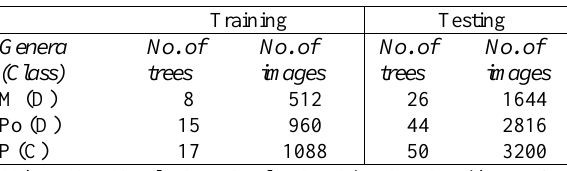
Table 1. Training and testing data partition for the experiments